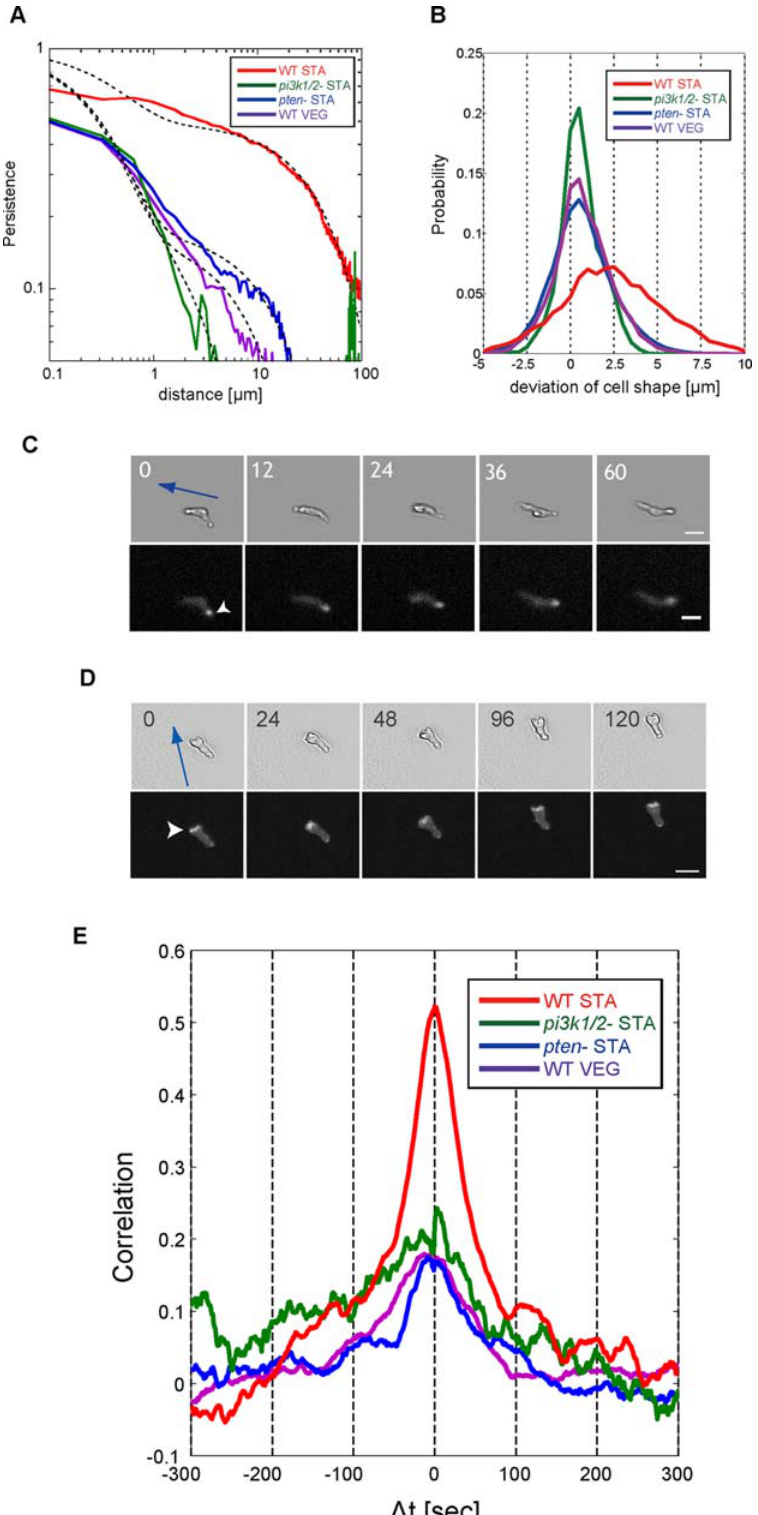
Figure 6. Coordination of cell movement with ordered patterns. (A) Persistence of directional motion as a function of distance in WT cells and mutants. Slow decay of persistence represents the sustainable straight motion. Red: WT STA cells, Purple: WT VEG cells, Blue: pten 2 STA cells, Green: pi3k 1/2 2 STA cells. The curve of persistence is well fitted by the double exponential function (black dash line). (B) Spontaneous symmetry breaking of cell polarity. Probability distribution of the deviation of cell shape of the direction of migration ( Amp h V ( t ), t ð Þ ). Red: WT STA cells, Purple: WT VEG cells, Blue: pten 2 STA cells, Green: pi3k 1/2 2 STA cells. (C) and (D): Spontaneous asymmetric localization of (C) PTEN and (D) F-actin. Blue arrow denotes the direction of cell movement. White arrowhead denotes the localization area. Scale bar is 20 m m. The number indicates time of measurement [second]. (E): Identical angle cross-correlation function between Amp ( h ,t ) and V ( t ). Red: WT STA cells, Purple: WT VEG cells, Blue: pten 2 STA cells, Green: pi3k 1/2 2 STA cells. doi:10.1371/journal.pone.0003734.g006 PLoS ONE |